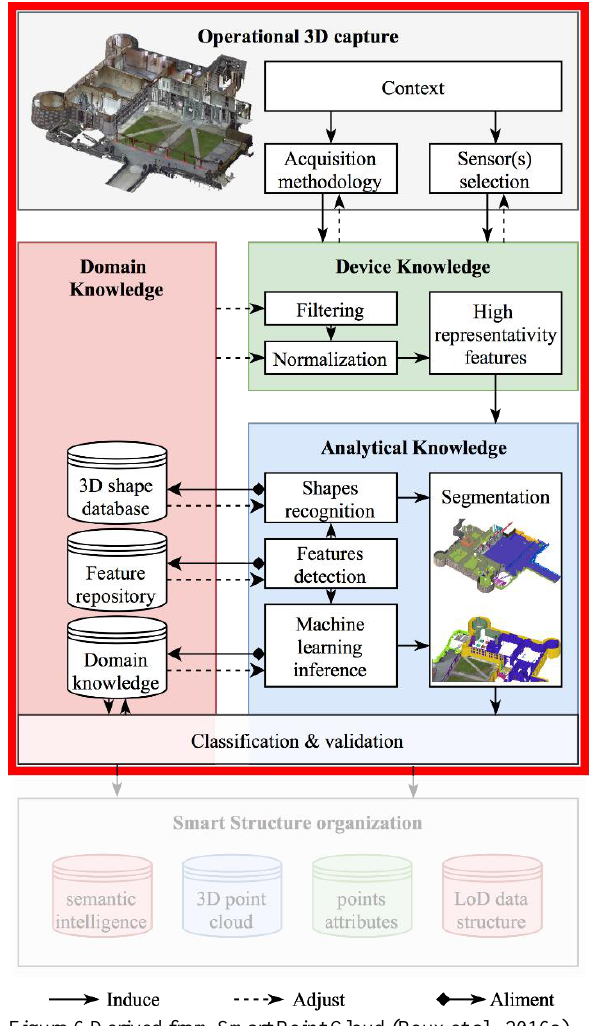
Figure 6 Derived from Smart Point Cloud (Poux et al., 2016a)